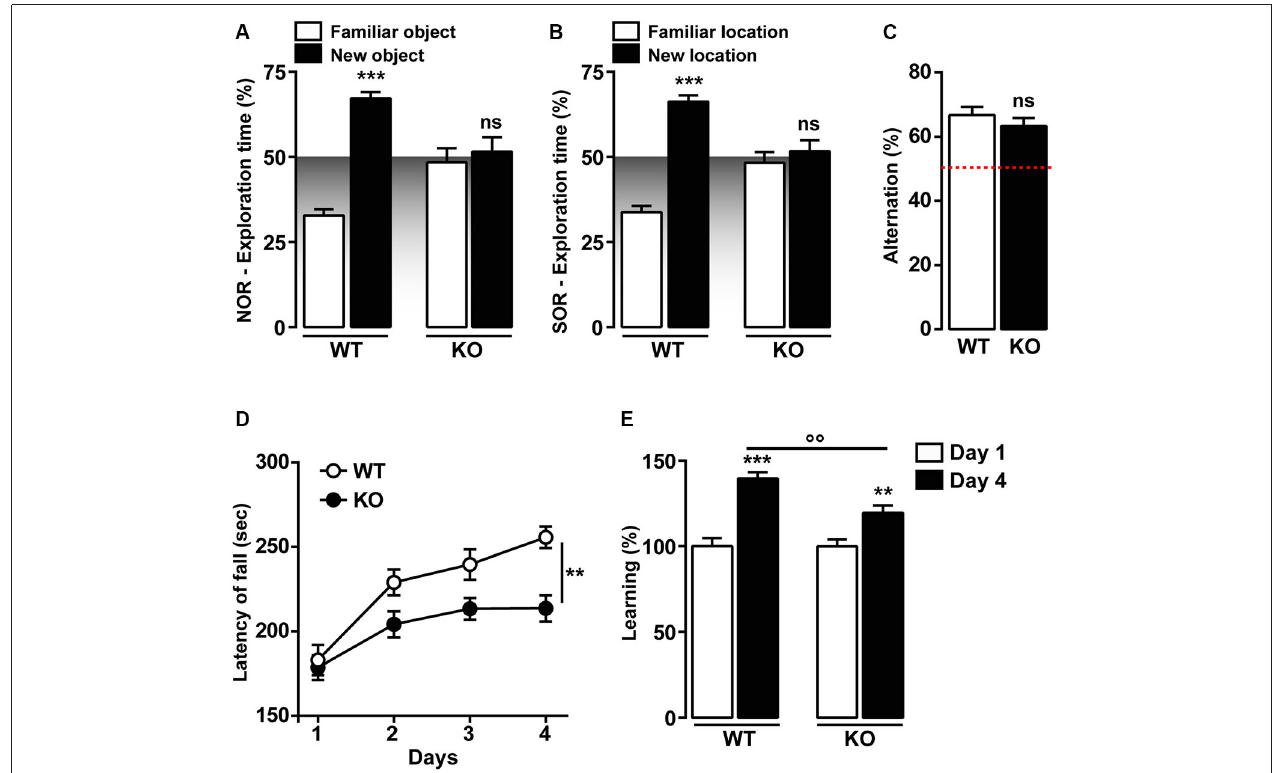
Y-maze test. The red dotted line represents the chance level of alternation (random, 50%). Data (means ± SEM) were analyzed using Student’s t -test: ns. (D) Curves show coordination and motor learning in WT ( n = 22) and Ca v 3.2 KO ( n = 22) mice over a training period of 4 days. Data (means ± SEM) were analyzed using two-way ANOVA (Time × Genotype: F ( 3,168 ) = 2.017, P = 0.1134; Time: F ( 3,168 ) = 19.03, P < 0.0001; Genotype: F ( 1,168 ) = 20.12, P < 0.0001). Specific comparisons: ** p < 0.01 (KO-Day4 vs. WT-Day4). (E) Percentage of motor learning in WT ( n = 22) and Ca v 3.2 KO ( n = 22). Data (means ± SEM) were analyzed using two-way ANOVA (Time × Genotype: F ( 1,84 ) = 5.643, P < 0.05; Time: F ( 1,84 ) = 5.654, P < 0.05; Genotype: F ( 1,84 ) = 49.11, P < 0.0001). Specific comparisons: *** p < 0.001 (WT-Day4 vs. WT-Day1), ** p < 0.01 (KO-Day4 vs. KO-Day1) and ◦◦ p < 0.01 (KO-Day4 vs.